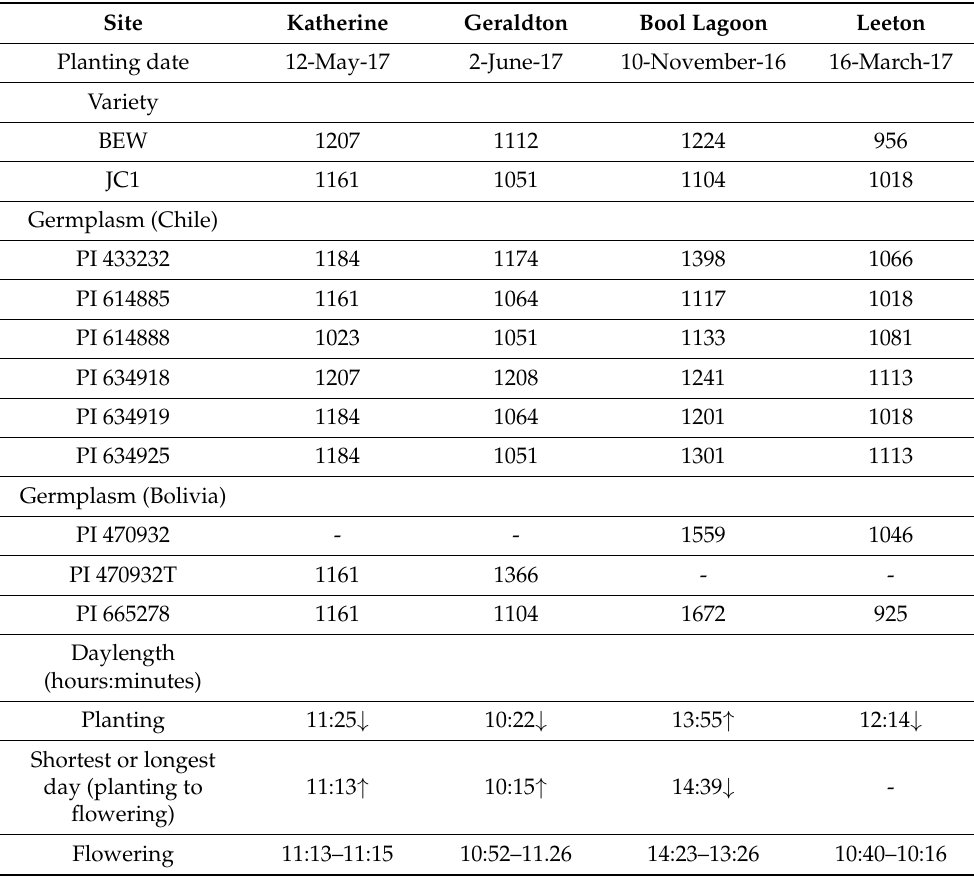
Table 6. Heatsums (sum of daily mean temperatures) from planting to commencement of flowering of varieties and germplasm lines and daylength (hours:minutes) between planting and flowering at selected trial sites (arrows indicate if daylength is increasing or